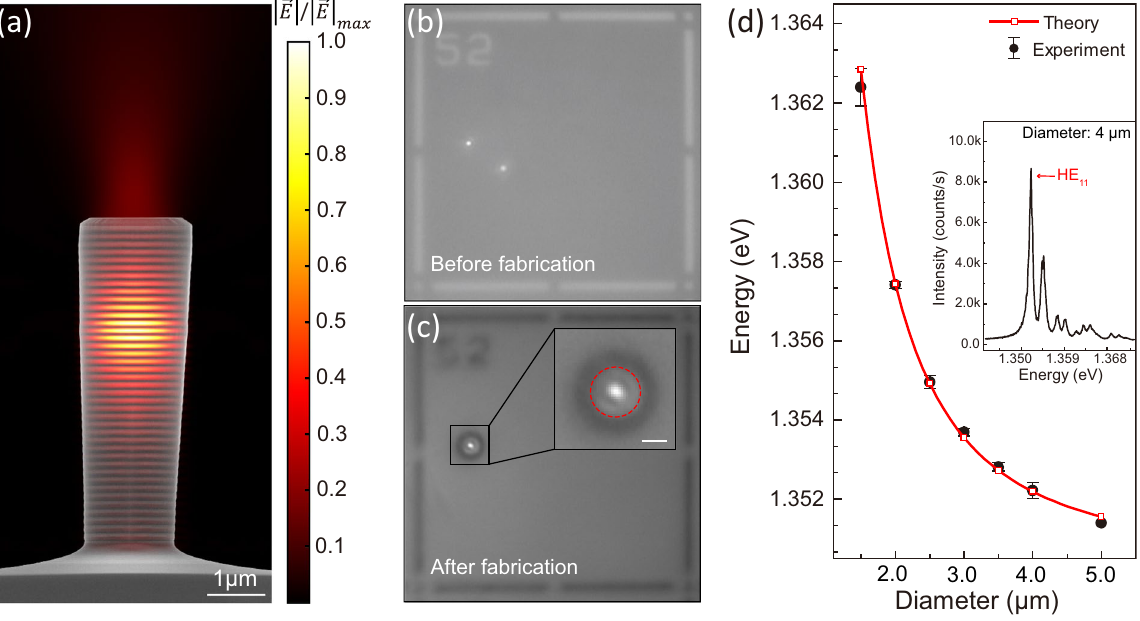
Figure 2. ( a ) Scanning electron microscopy (SEM) image of a typical pillar with a diameter of 2 μ m, along |→ | E calculated by 3D-FDTD method. ( b , c ) with the normalized electric field intensity distribution Photoluminescence images of a 4 μ m diameter micropillar with a single quantum dot in the center before ( b ) and after ( c ) fabrication. Scale bar represents 2 μ m. ( d ) The average of measured energy (black dot with error bar) of the fundamental mode (HE 11 ) for the pillar cavities as a function of the designed diameter, which are well described by theory according to Eq. (1) plotted in red line. Inset is a typical experiment cavity mode of a micropillar with a diameter of 4 μ m acquired by raising the excitation